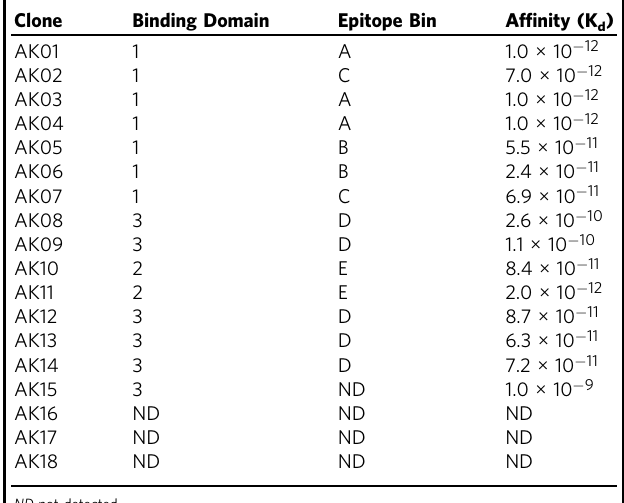
Table 1 Siglec-6 mAb